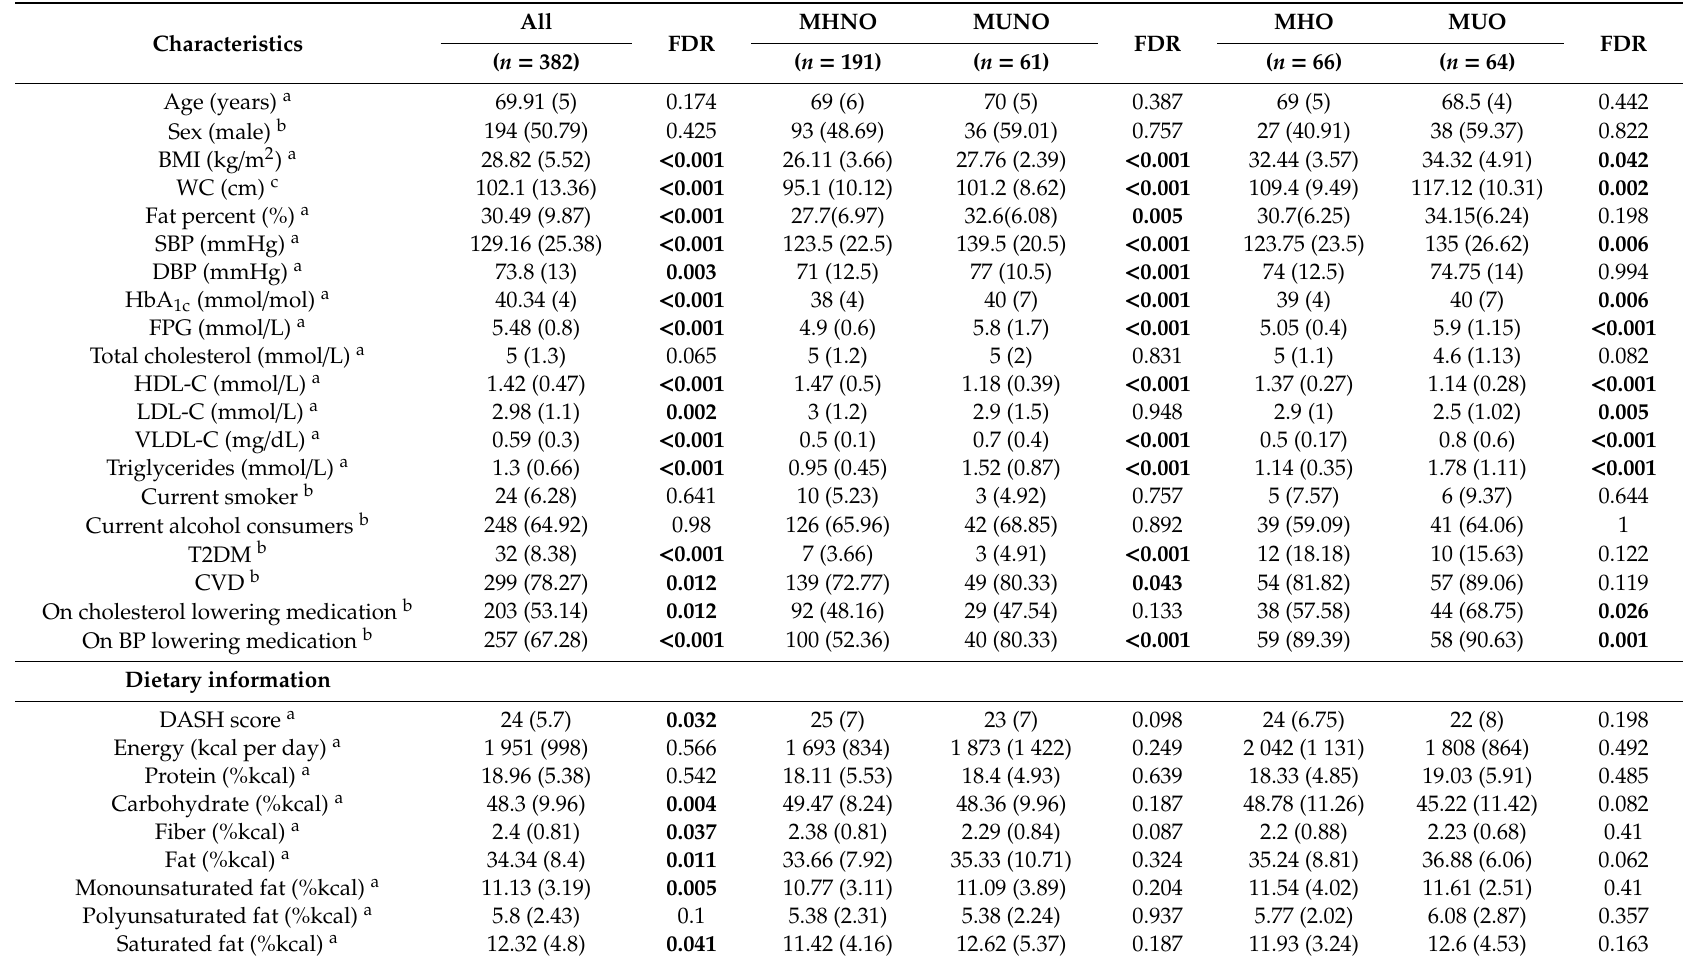
Table 1. Descriptive characteristics of the study population according to metabolic health